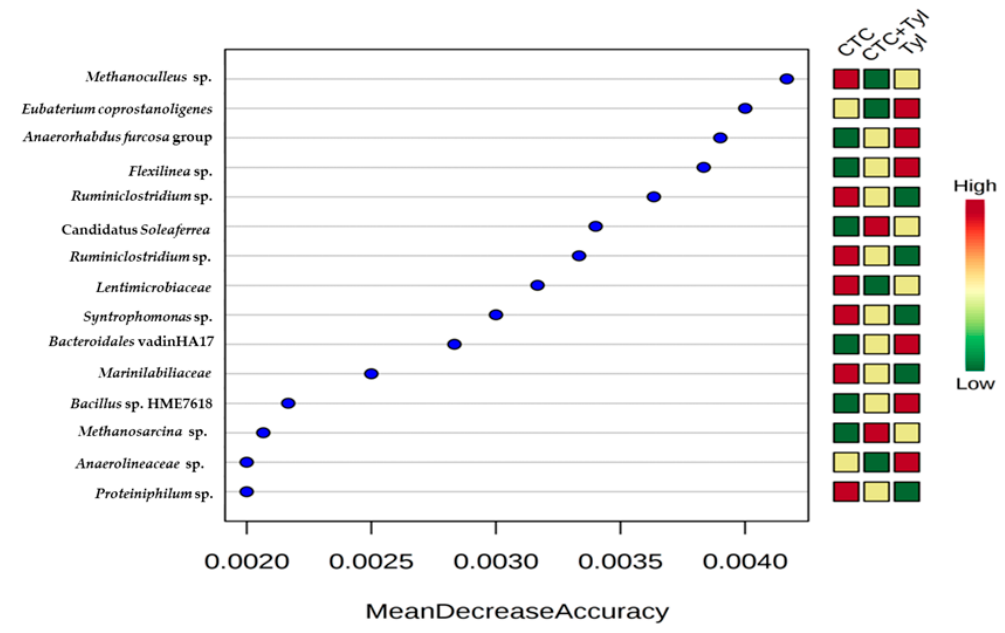
Figure 15. Random forest analysis of biomarkers based on MeanDecreaseAccuracy.